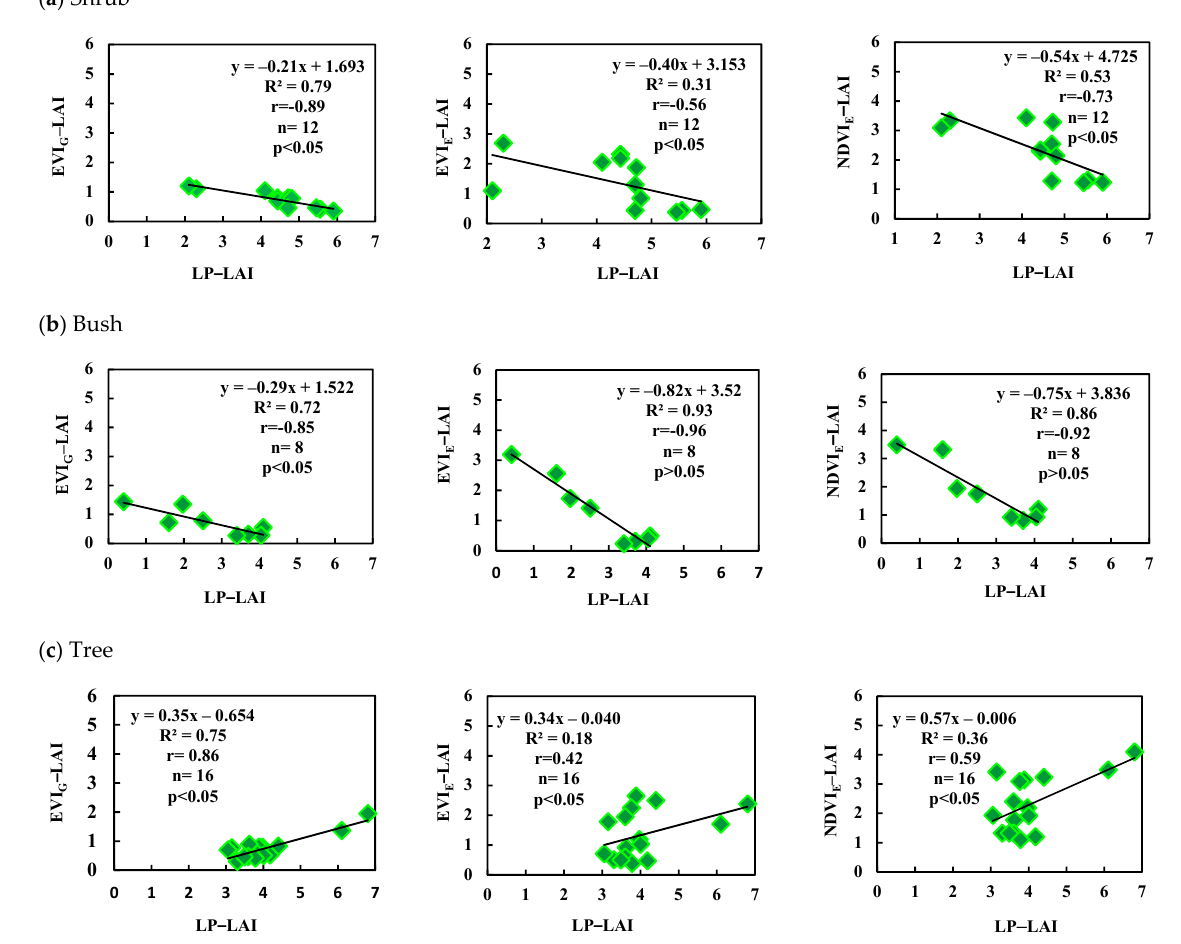
Figure 6. Scatter plots of remote sensing-based and LP 100 LAIs for different PFTs of ( a ) shrub, ( b ) bush, and ( c ) tree.